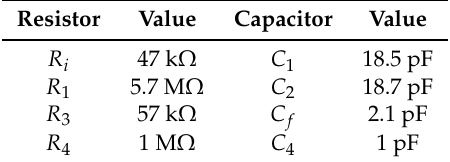
Table 5. Passive component values in the third-order ΣΔ modulator (example